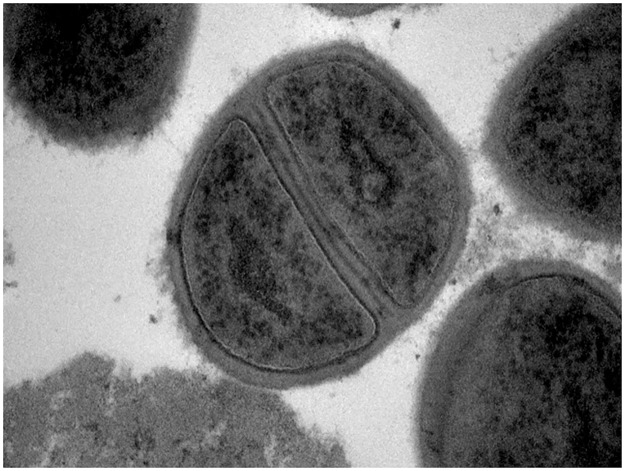
TEM image showing a closer view of rapidly dividing Staphylococcus epidermidis cells in a nipple biopsy from a woman with presumptive signs of “mammary candidiasis”.